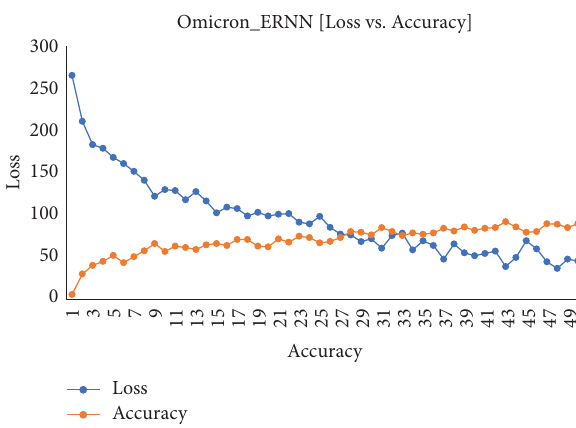
Figure 8: Omicron disease ERNN data: accuracy vs. loss vs.